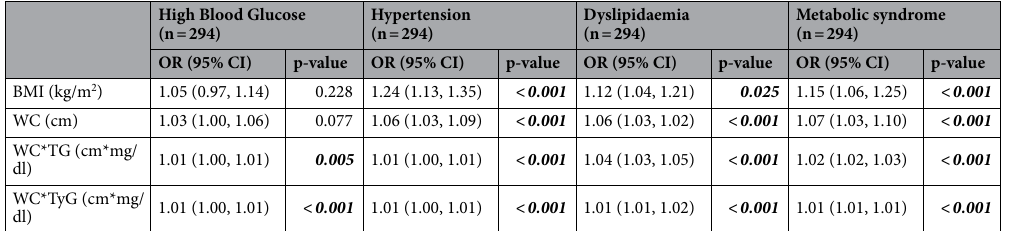
Table 2. Associations between indices (measured as continuous variables) and individual metabolic syndrome manifestations. Adjusted by age, sex, physical activity, total energy intake, adherence to a Mediterranean diet, family history of obesity and education level.